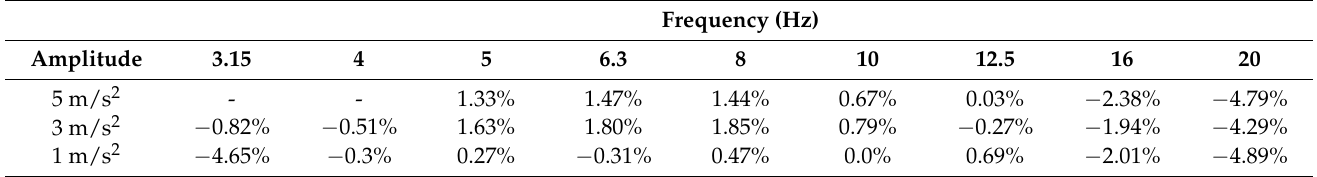
Table 2. Percentage of deviation of the smartwatch compared to the reference